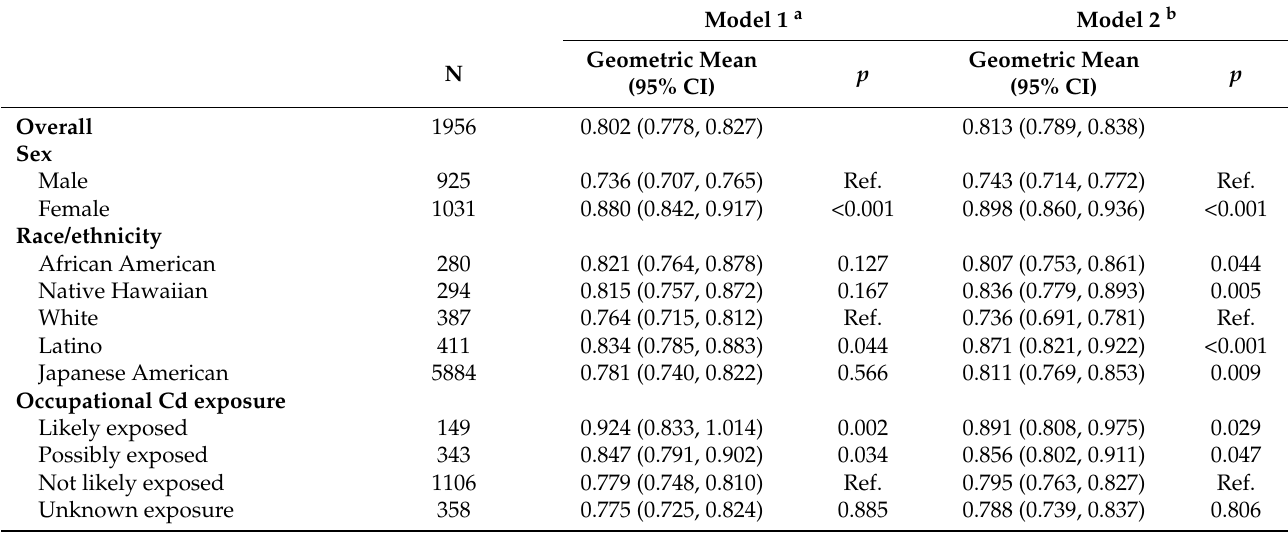
Figure 1. Median levels of urinary Cd (natural log of ng/mL) in MEC current smokers, overall and by race/ethnicity. The box represents the interquartile range (25th and 75th percentile), the dark line across the box represents the median value (50th percentile), the bottom and top whisker represents the first and 99th percentile and the circles above and below the whiskers represent outliers (>1.5 × and <3 × the interquartile range). Table 2. Geometric mean (95% CI) of urinary cadmium concentration (ng/mL) by sex, race/ethnicity and occupational cadmium exposure categories among MEC current